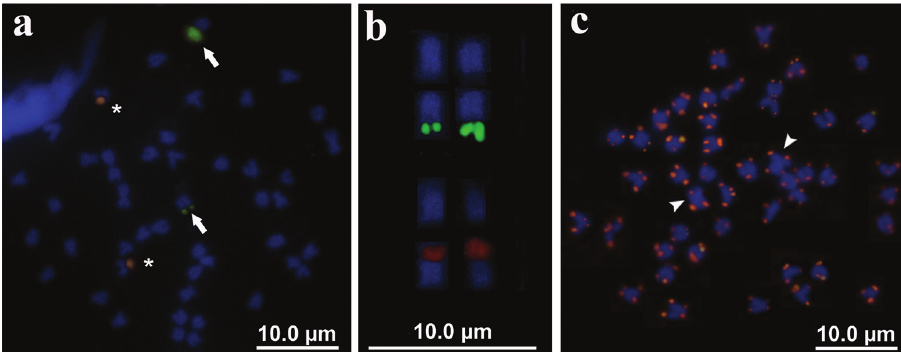
Figure 4. Somatic metaphases of the Pacific white mullet showing positive sites after FISH ( a ) with 18S rDNA (arrows) and 5S rDNA (asterisks) probes and ( c ) with telomeric repeats. Arrowheads indicate chromosome pair number one. In ( b ) enlargement of selected samples of chromosome pairs 15 and 20, after DAPI staining and FISH with rDNA probes, showing 18S (above) and 5S (below) positive sites, respectively. Scale bar: 10